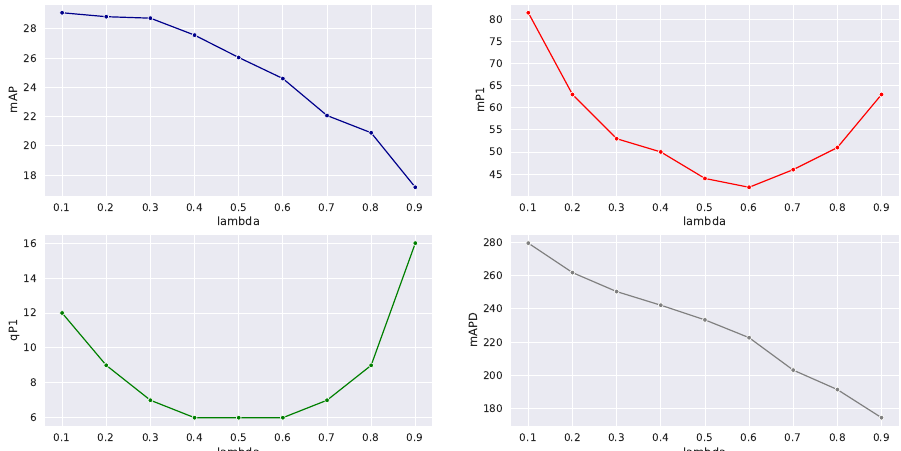
Figure 11. Evolution of the absolute mAP and various inter-domain measures against λ with the cMD method.